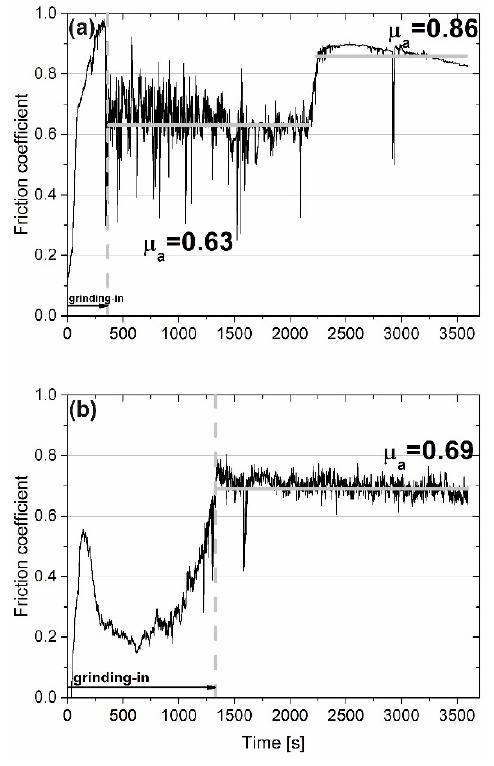
Figure 4. Results of wear test conducted at 200 °C for sintered Ni-50%NiCr(80/20) ( a ) and Ni-